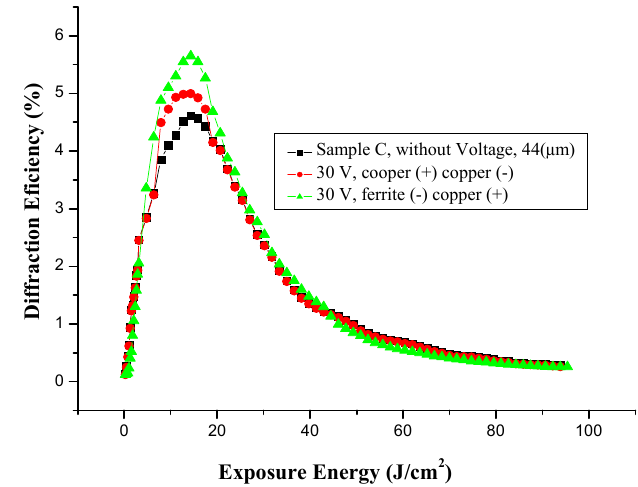
Figure 15. Diffraction efficiency of 30 V voltage with thickness of 44 µm of sample C with a frequency of 1132 lines/mm, using different electrodes.